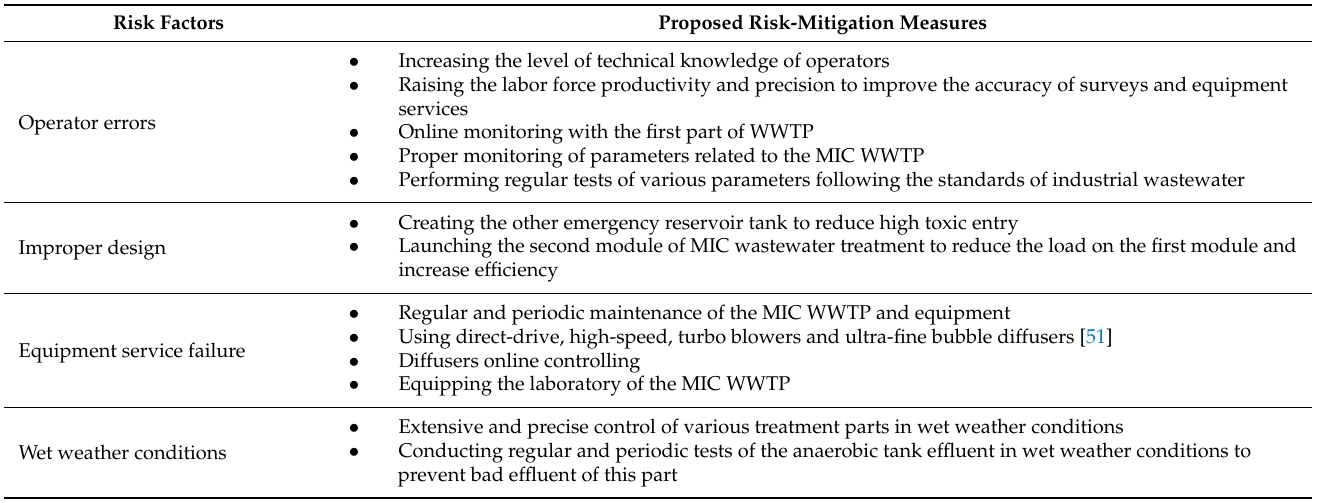
Table 5. The proposed risk-mitigating measures of the MIC WWTP.